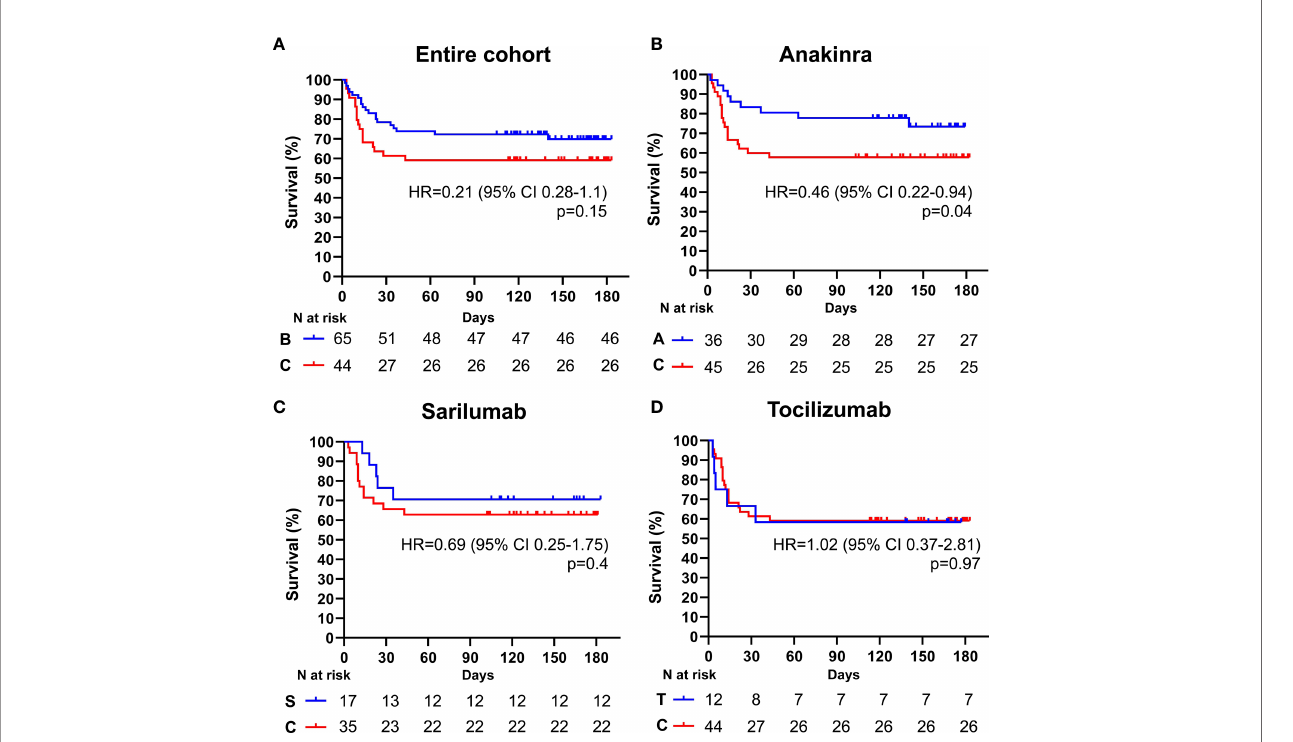
FIGURE 3 | Cumulative incidence of long-term survival of patients treated with biologic drugs compared to patients treated with standard of care (PaO2/FiO2 ratio < mmHg). Kaplan-Meier curves showing the cumulative incidence of overall survival up to 186 days of patients presenting with a PaO2/FiO2 ratio < mmHg and treated with biologic drugs (A) , anakinra (B) , sarilumab (C) , and tocilizumab (D) , compared to standard of care. Time to death is expressed in days from the day of enrolment. A, anakinra; B, biologic drugs; C, comparators treated with standard of care; S, sarilumab; T, tocilizumab; HR, hazard ratio; CI, con fi dence interval. Statistically signi fi cant p value <